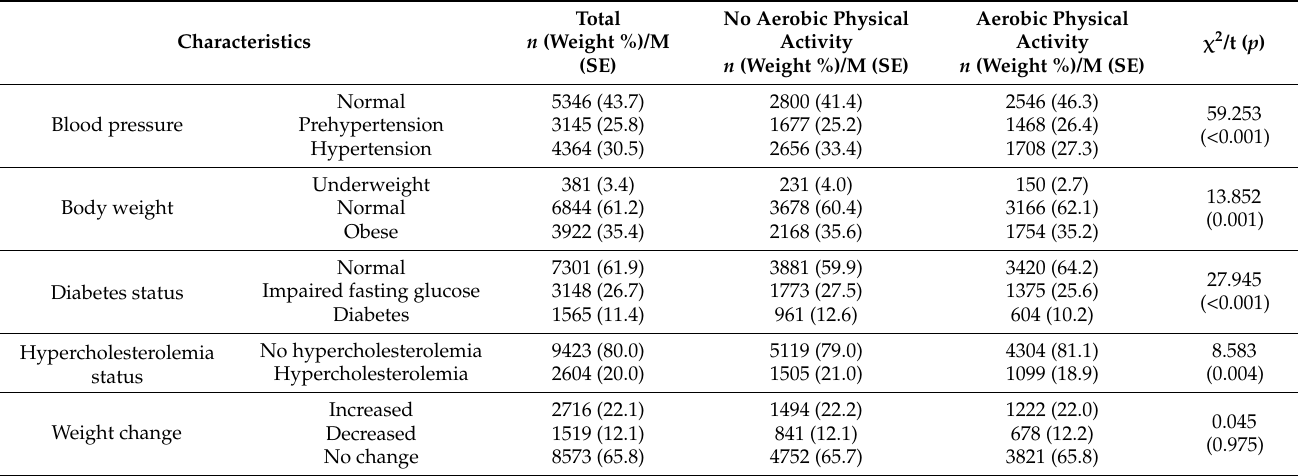
Table 2. Comparison of the no aerobic physical activity and aerobic physical activity groups in terms of physical and psychological factors ( n =